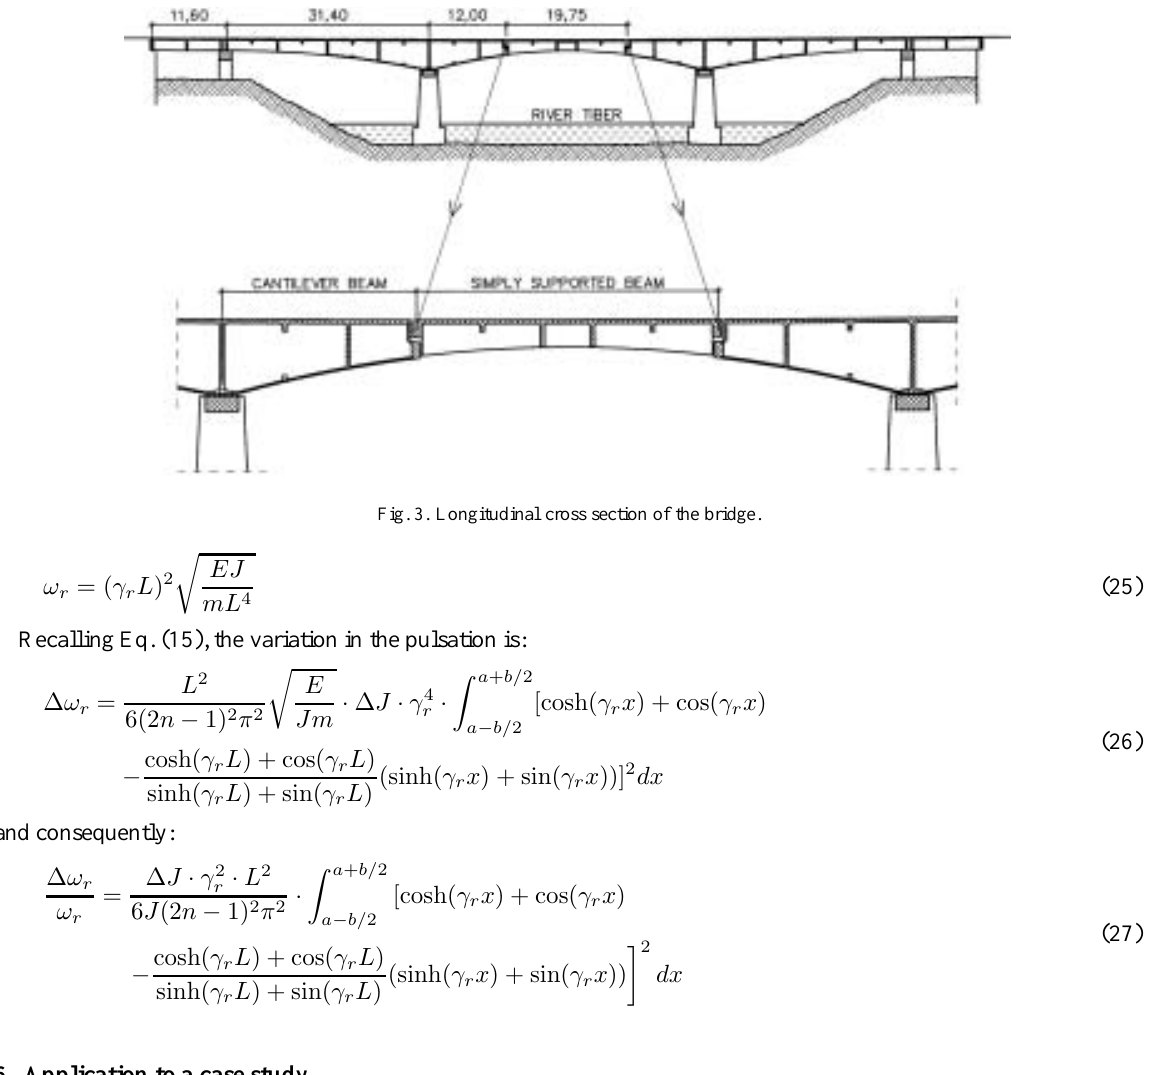
Fig. 3. Longitudinal cross section of the